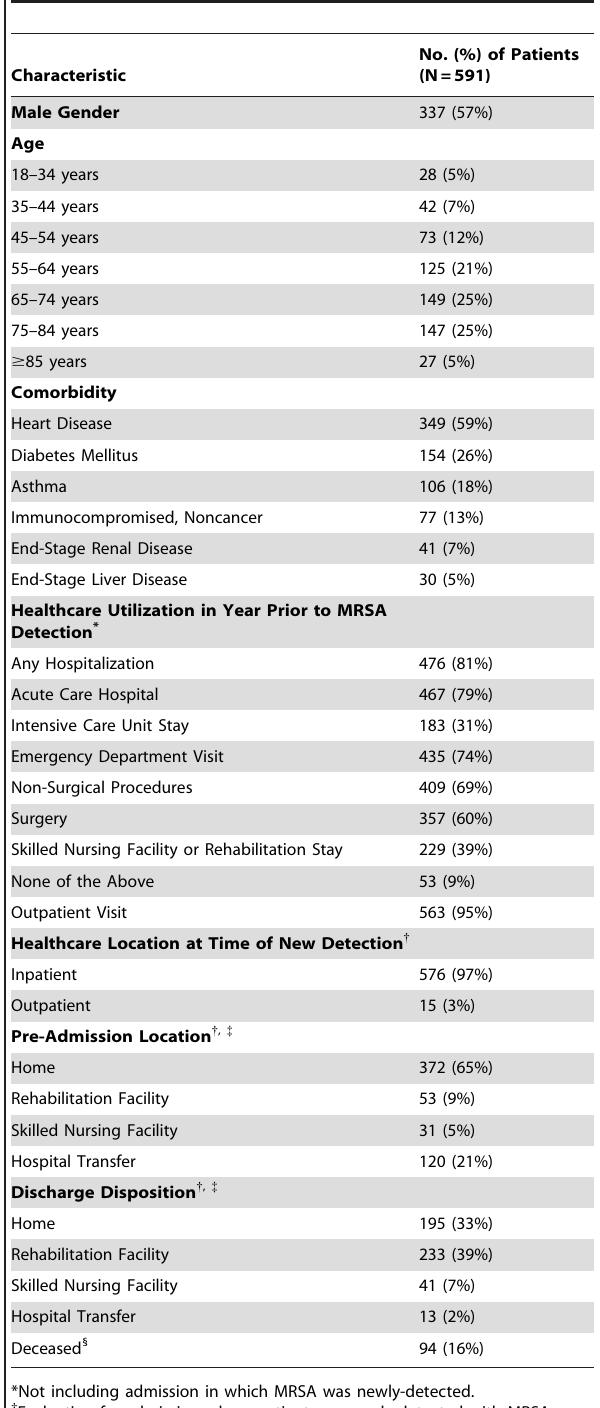
Table 1. Characteristics of Patients at Time of New Detection with Methicillin-Resistant Staphylococcus aureus